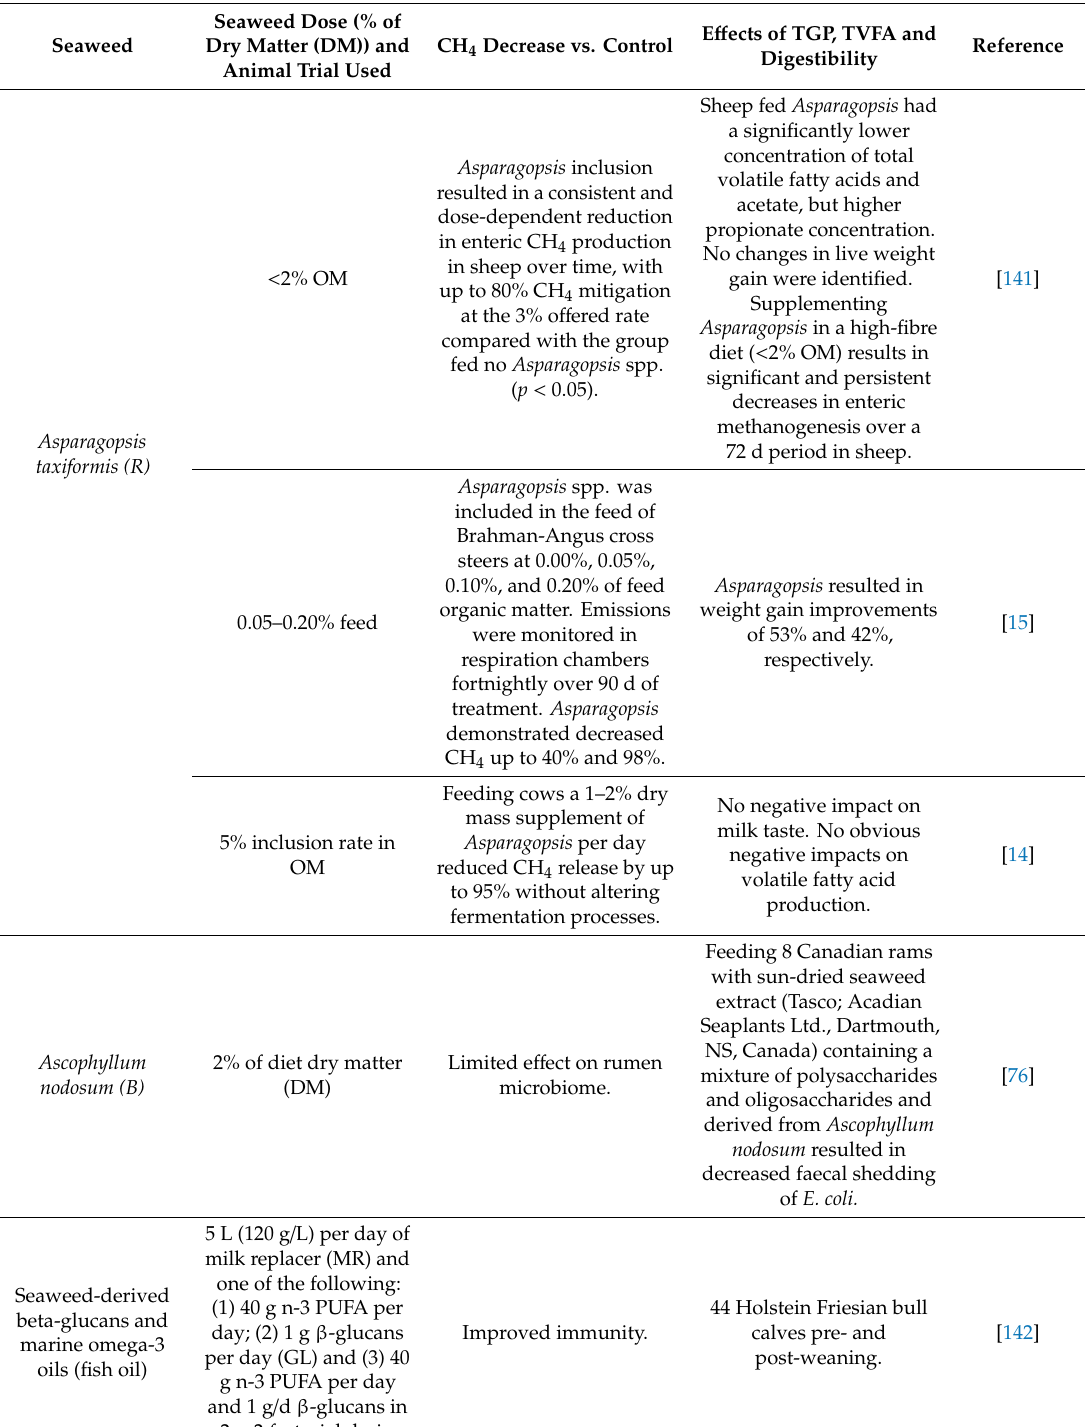
Table 6. Summary of seaweeds with CH 4 mitigation e ff ects in